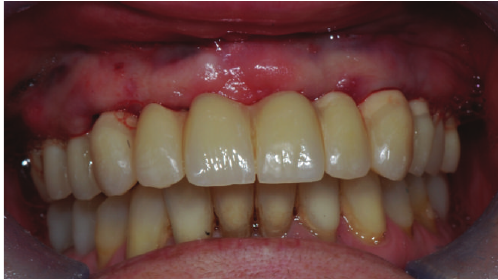
Figure 4: Immediate loading with screw-retained temporary pros-